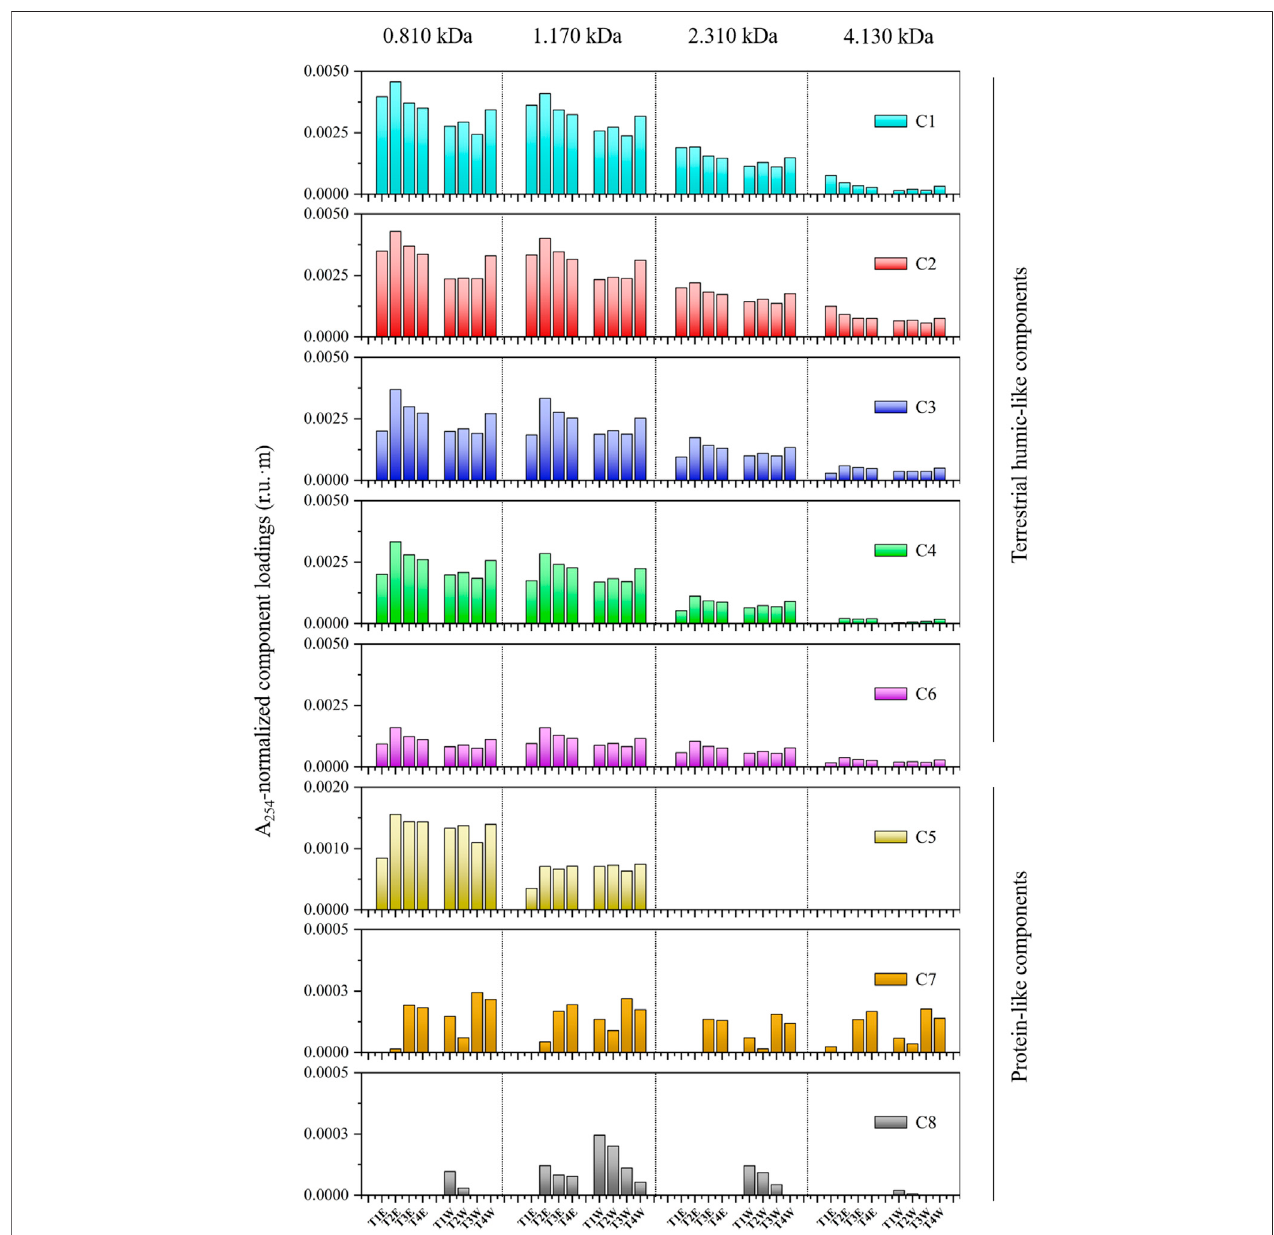
FIGURE 7 | A 254 -normalized PARAFAC component loadings (r.u. · m) across size fractions for terrestrial humic-like components (C1 – C4 and C6) and protein-like components (C5, C7, and C8) found in this study. Samples are collected at four mainstem transects including the east (T1E – T4E) and west sides (T1W – T4W) along the